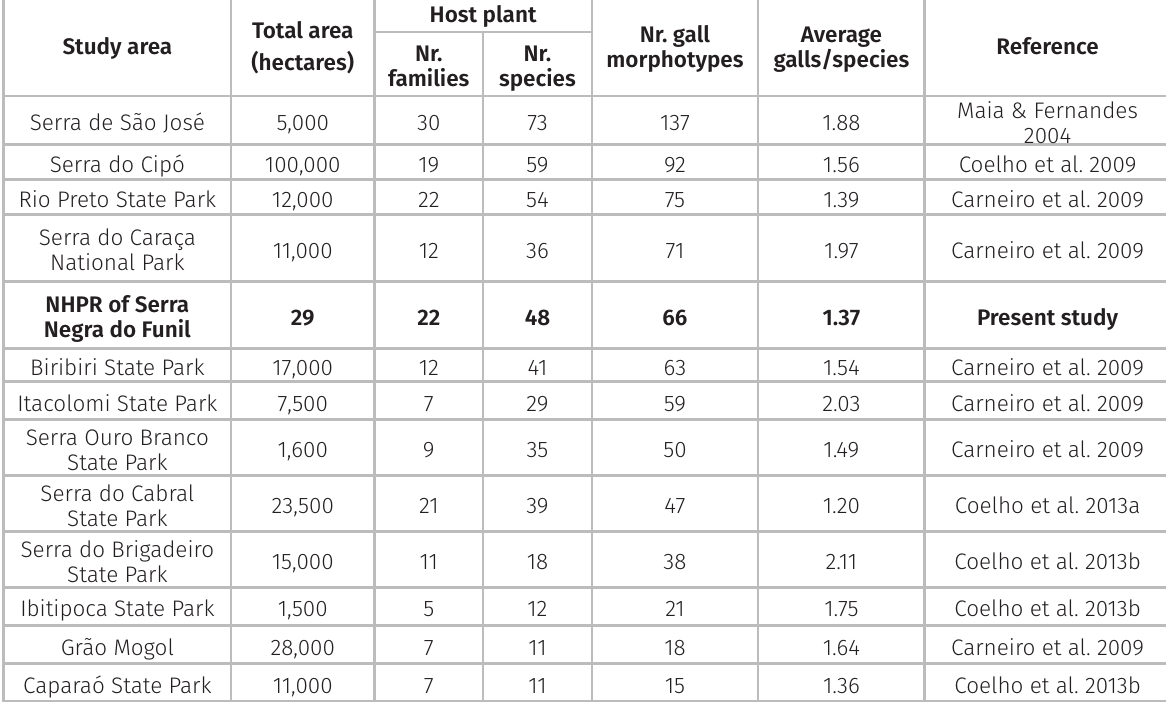
Table VIII. Data on gall richness, number of host plants and average of gall morphotypes per species in other study areas in Minas Gerais,